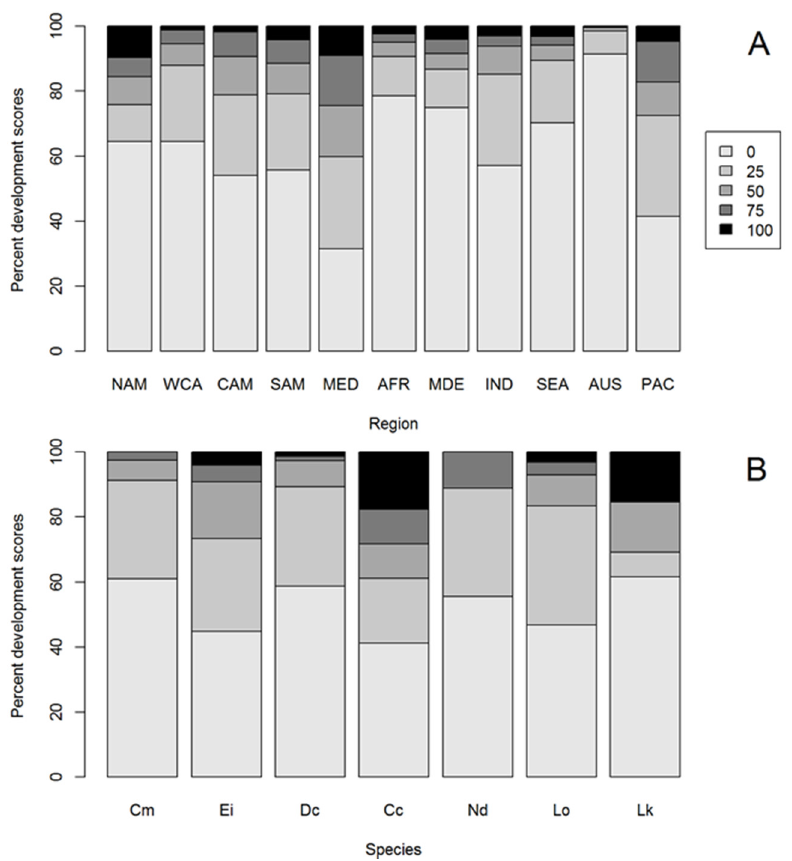
Figure 2. Stacked bar plots displaying the proportion of hard anthropogenic coastal development (HACD) scores for ( A ) turtle nesting regions ordered by longitude (NAM—North America, WCA— Western Central America, CAM—Central America, SAM—South America, MED—Mediterranean, AFR—Africa, MDE—Middle East, IND—Indian Ocean, SEA—South East Asia, AUS—Australia, PAC—Pacific Islands) and ( B ) marine turtle species (Cm—green, Ei—hawksbill, Dc—leatherback, Cc—loggerhead, Nd—flatback, Lo—olive ridley, Lk—Kemp’s ridley) where 0 = no HACD behind the nesting beach and 100 = all land behind the nesting beach was backed by HACD.